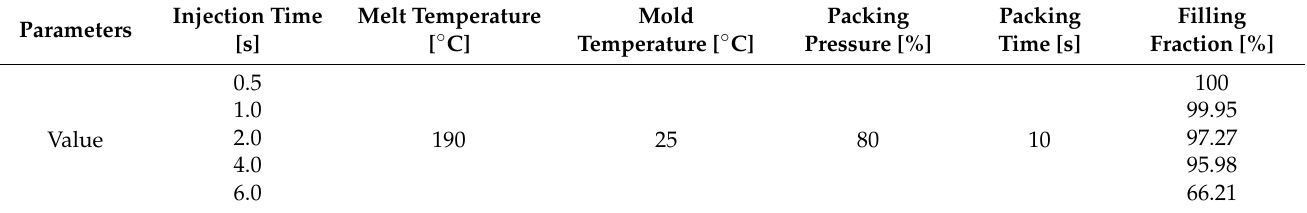
Table 3. Processing parameters of the injection time study. Only injection time was